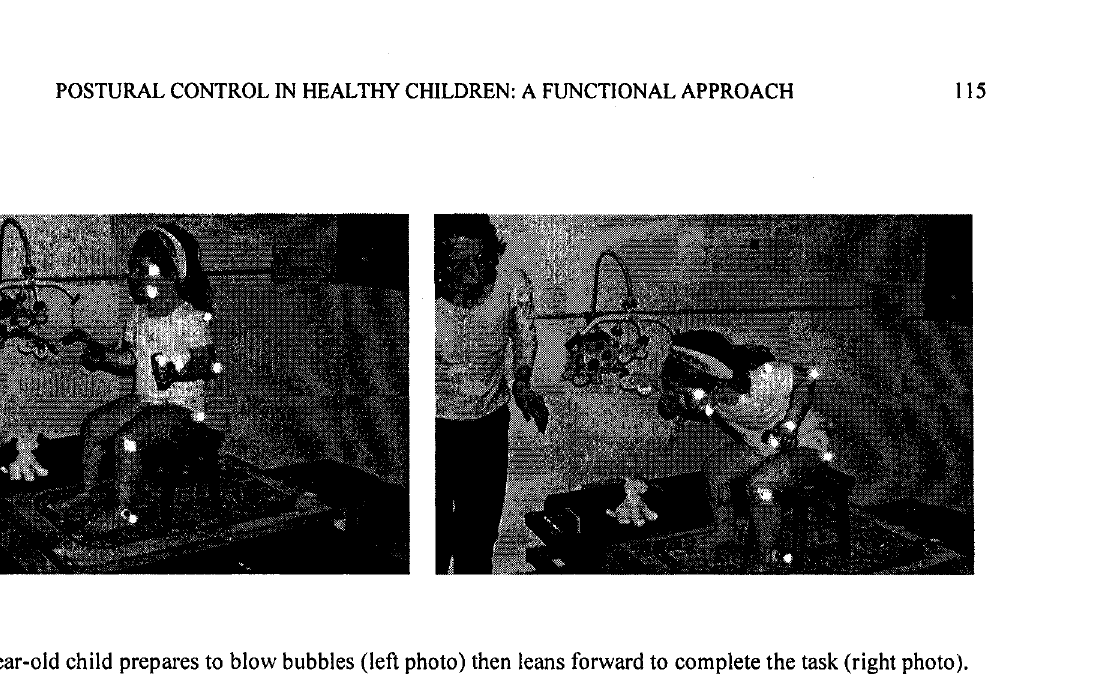
Fig. 3: A 2-year-old child prepares to blow bubbles (left photo) then leans forward to complete the task (right photo). The photo shows the child’s use of an egocentric rather than an exocentric reference frame, as she maintains a relatively constant angle between the forearm and the trunk. Little effort is made to orient the forearm (and bottle) to the vertical line of